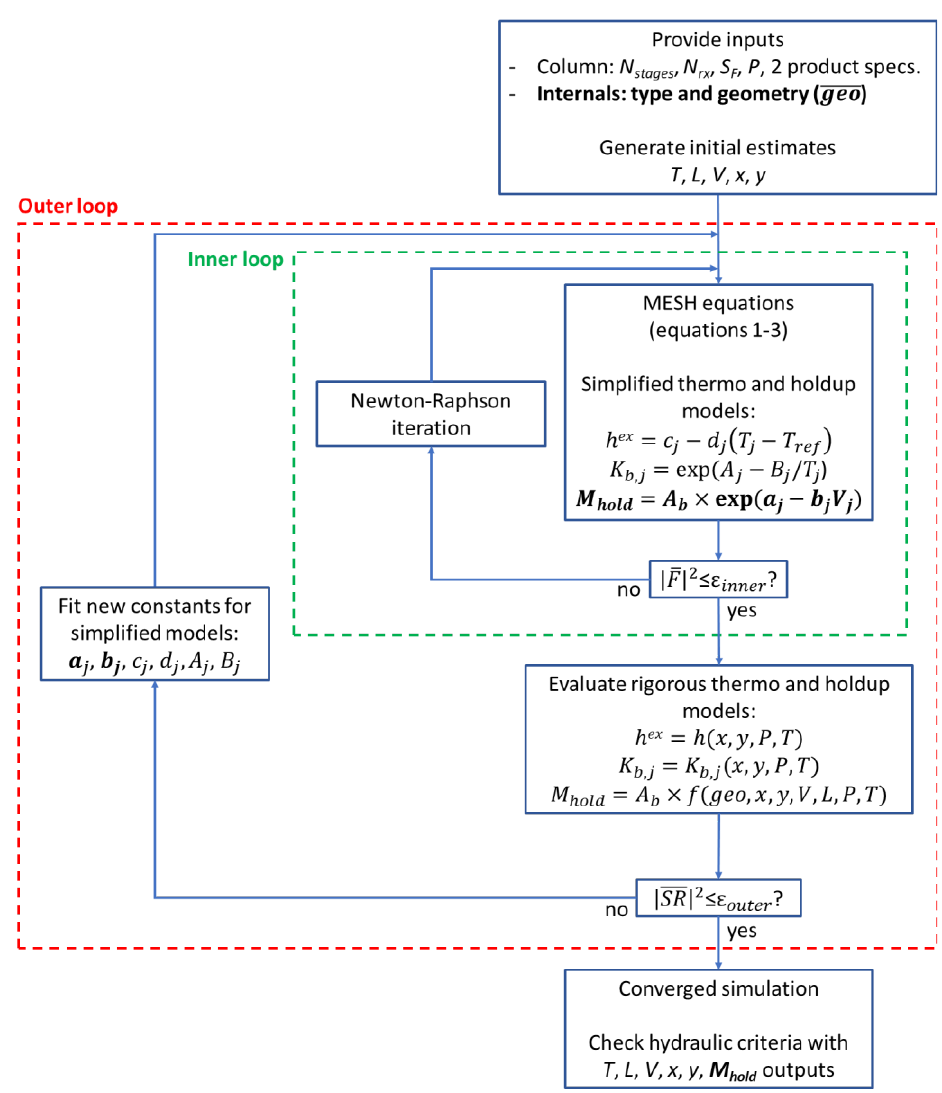
Figure 2. Overview of the inside-out algorithm with the proposed liquid holdup model.